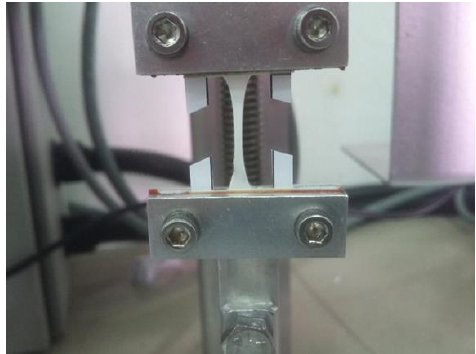
Figure 3. Set up of sample position in tensile test.